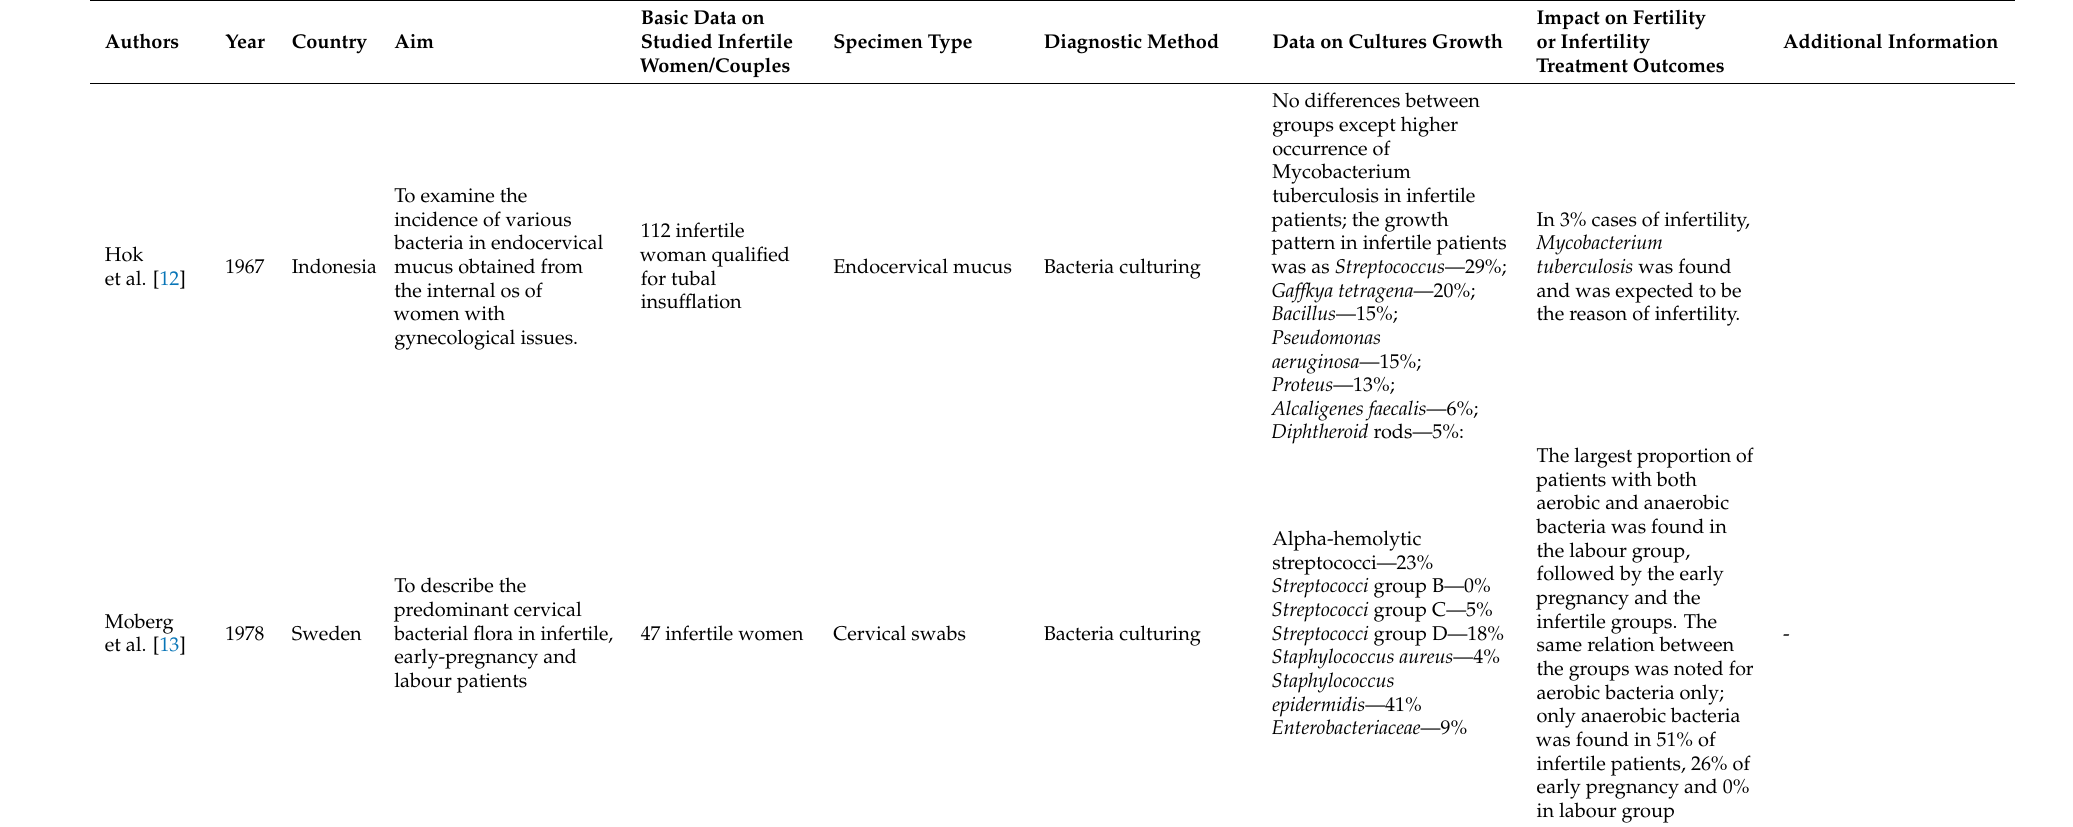
Table 2. Synoptic overview of the articles included in the